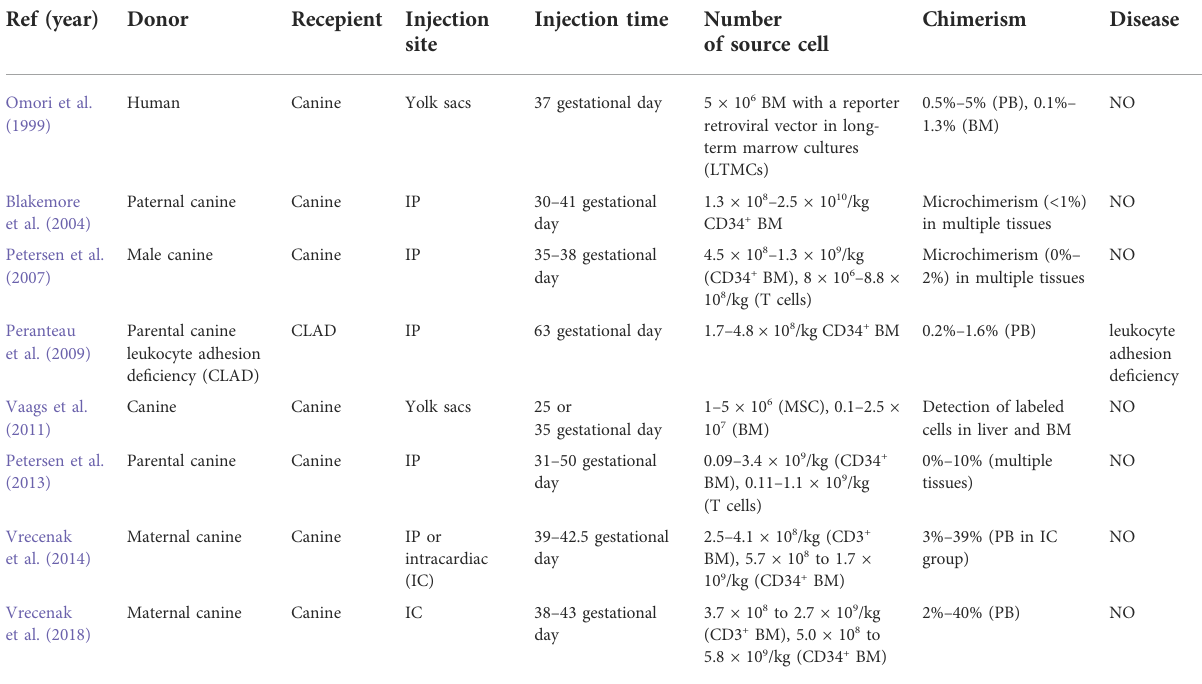
TABLE 3 IUT in canine